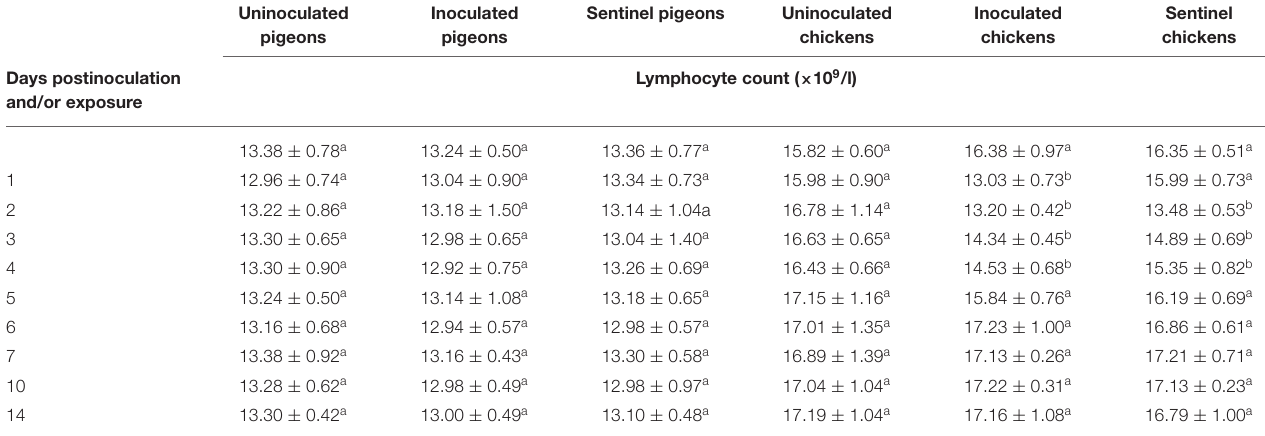
TABLE 6 | Mean lymphocyte count of pigeons and chickens following inoculation with and/or exposure to a very virulent infectious bursal disease virus.